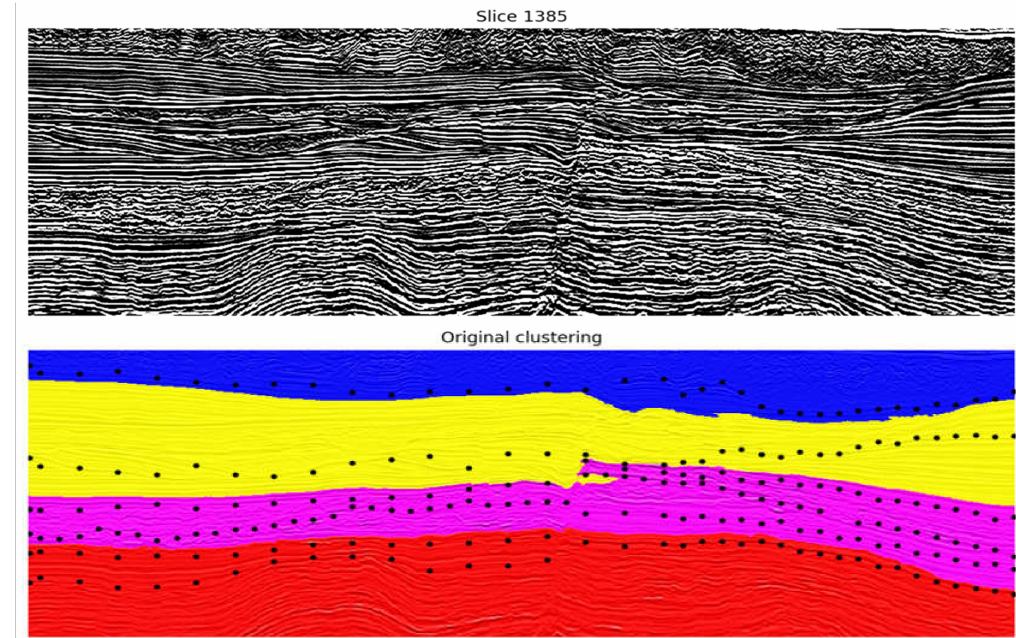
Figure 15. Results from the clustering of Watershed segments using k-Means (4 groups) and an image composed of Texture Contrast, Amplitude, Similarity Cross Average. The top image shows the original vertical seismic slice; the bottom one shows the Watershed results. Black dots in the lower figure indicate main geological boundaries according to geophysicist interpretation of the top figure (conventional seismic data). One can conclude that a good fit occurs between clustering results and geophysicist’s preliminary